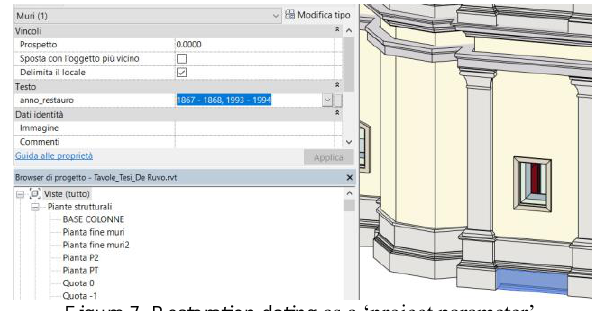
Figure 7. Restoration dating as a ‘project